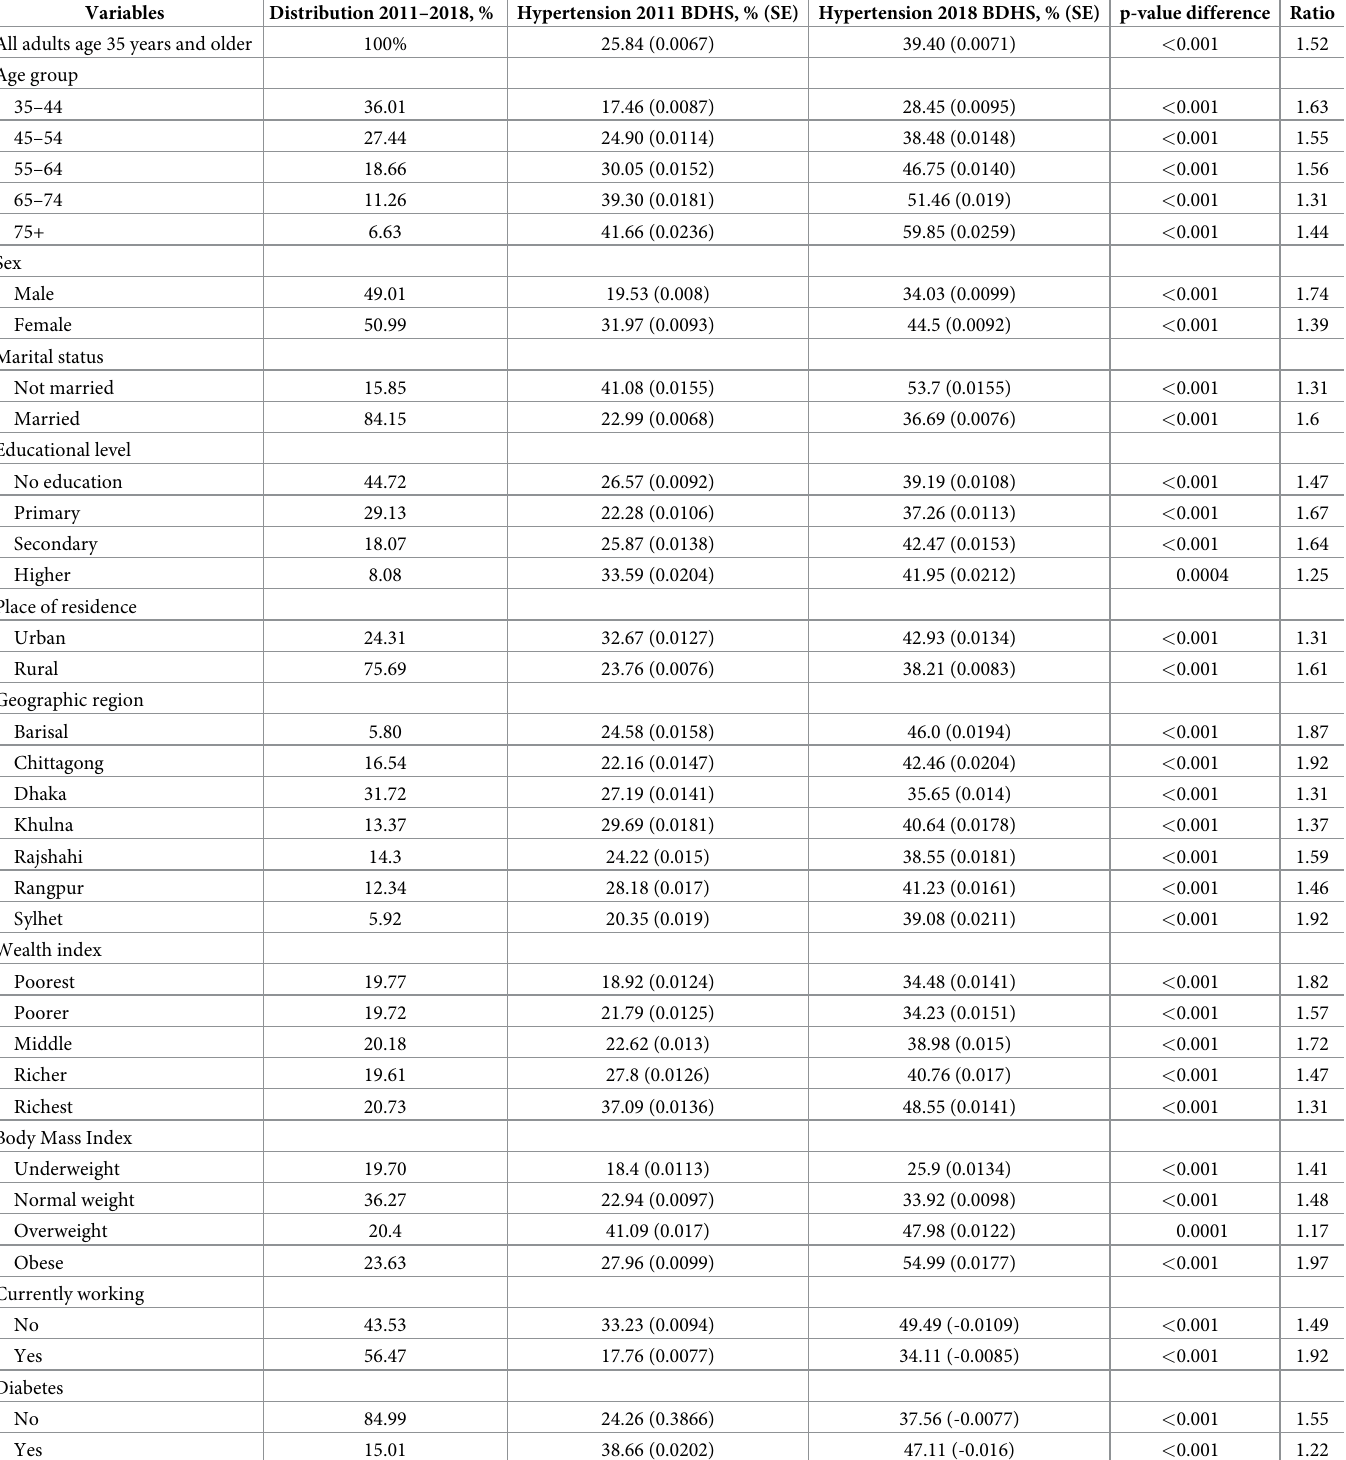
Table 1. Sociodemographic characteristics of adults age 35 years and older and hypertension rate in Bangladesh,